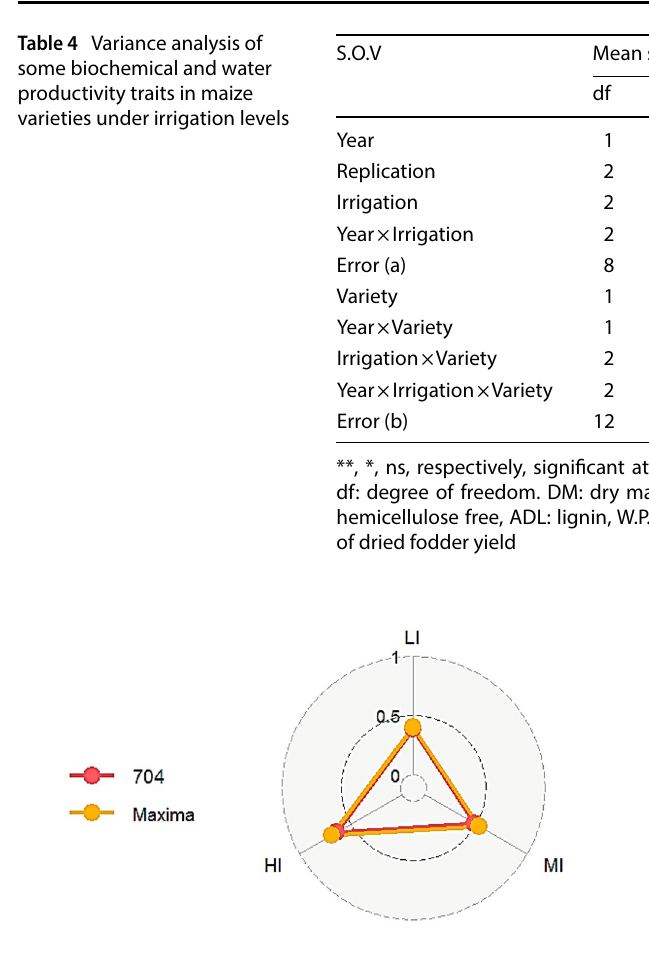
Fig. 1 Radar plot comparing wet forage yield of two maize varieties under different irrigation levels (LI: light irrigation (60% full irriga- tion), MI: moderate irrigation (80% full irrigation), and HI: high irri- gation (100%))